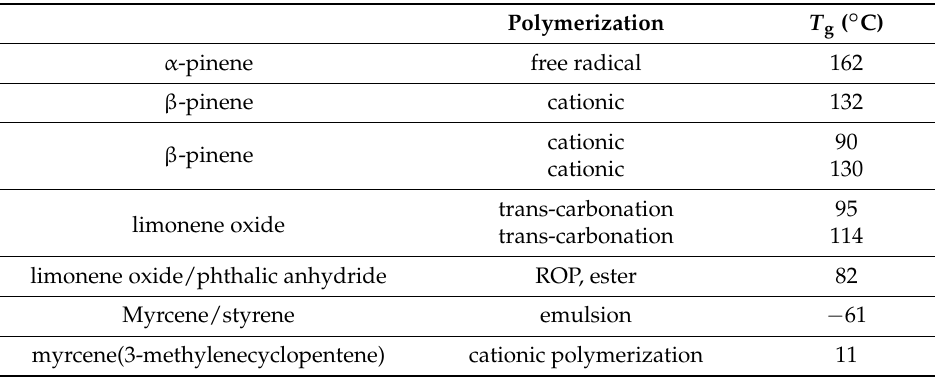
Table 9. Polymerization process and thermal properties of polyterpenes